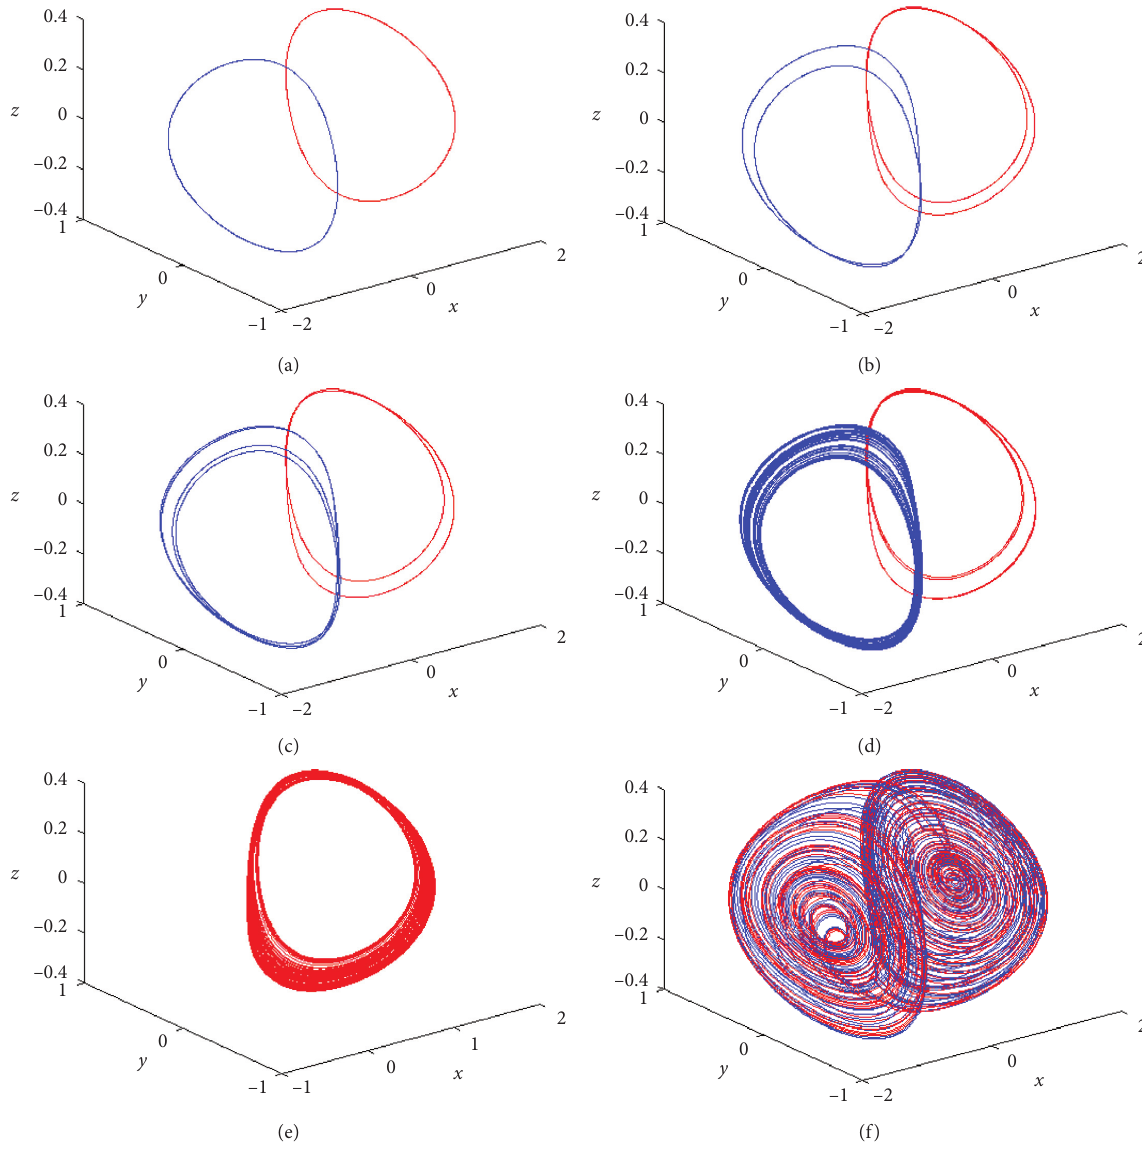
Figure 5: Three-dimensional representations ( x − y − z ) of trajectories in the phase space, at different points of the bifurcation diagram of the asymmetry system (Figure 2(a)), for different values of b with m � 0.05: (a, b) cycle of period-1 for b � 0 . 22 and cycle of period-2 for b � 0 . 25; (c) cycles of period-4 and period-2 for b � 0 . 2824; (d) single-band chaotic attractor with cycle of period-4 for b � 0 . 2856; (e, f) single and chaotic dual-band attractor for b � 0 . 2892 and b � 0 . 3, respectively. The initial conditions are ( x ( 0 ) , y ( 0 ) ,z ( 0 )) � ( 0 . 25 , 0 , 0 ) and (− 0 . 25 , 0 , 0 ) for the traces in red and blue,